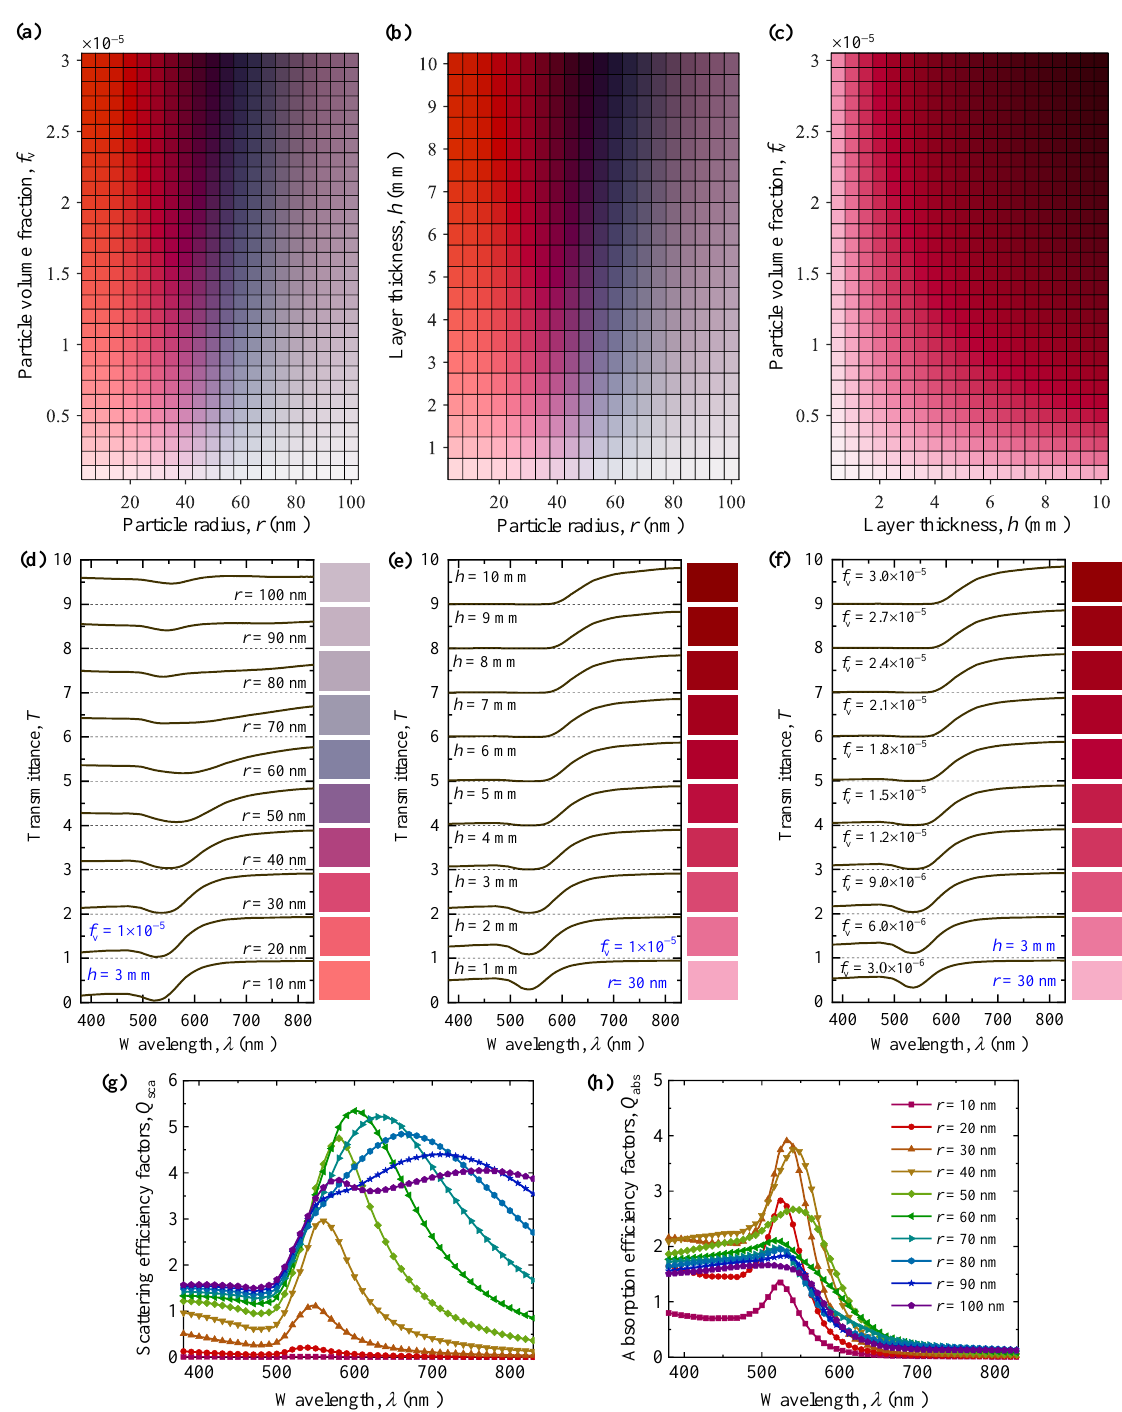
Figure 4. The generated colors of gold nanoparticle systems for different geometric parameters with ( a ) h = 3.0 mm, ( b ) f v = 1 × 10 − 5 , and ( c ) r = 30 nm. The simulated transmittance spectra of gold nanoparticle systems with ( d ) h = 3.0 mm, f v = 1 × 10 − 5 , and different particle radii; ( e ) f v = 1 × 10 − 5 , r = 30 nm, and different layer thicknesses; and ( f ) r = 30 nm, h = 3.0 mm, and different particle volume fractions. Note that the curves in Figure 4d – f with different geometric parameters are successively displaced upward by 1 for better visibility and comparison. ( g ) The scattering and ( h ) absorption efficiency factors of single particles for different particle radii.